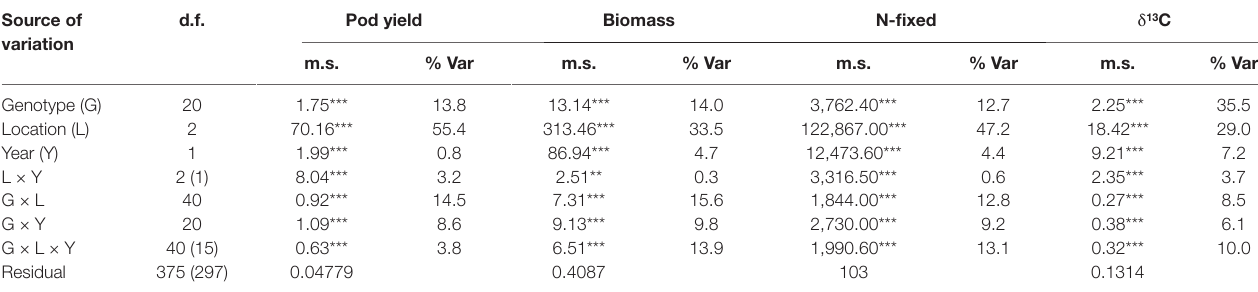
TABLE 4 | ANOVA of pod yield, shoot biomass, N-fixed, and shoot δ 13 C values of 21 groundnut genotypes tested at three locations over 2 years. Source of d.f. Pod yield variation